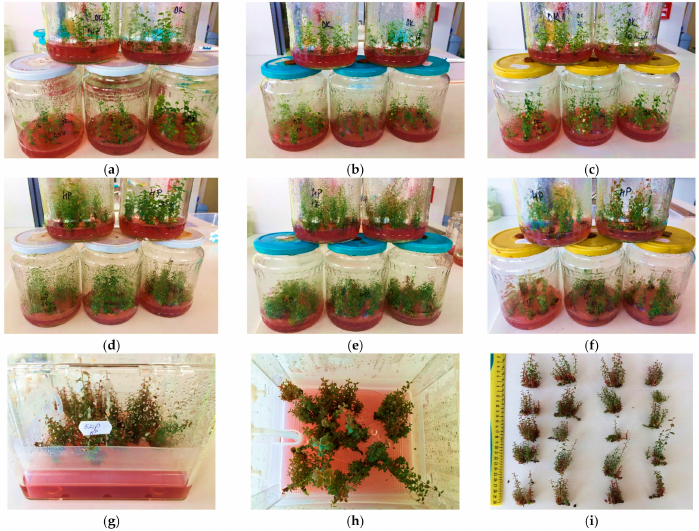
Figure 1. In vitro propagation of V. corymbosum L. cvs Duke and Hortblue Petite: ( a ) Duke after 12 weeks of in vitro culture in WPM medium (McCown’s Woody Plant medium) supplied with 0.5 mg/L zeatin (Z) and gelled with 5 g L Plant agar; ( b ) Duke after 12 weeks of in vitro culture in WPM medium supplied with 1 mg/L Z and gelled with 5 g/L Plant agar; ( c ) Duke after 12 weeks of in vitro culture in WPM medium supplied with 5 mg/L N6-(2-Isopentenyl) adenine (2iP) and gelled with 5 g/L Plant agar; ( d ) Hortblue Petite after 12 weeks of in vitro culture in WPM medium supplied with 0.5 mg/L Z and gelled with 5 g/L Plant agar; ( e ) Hortblue Petite after 12 weeks of in vitro culture in WPM medium supplied with 1 mg/L Z and gelled with 5 g/L Plant agar; ( f ) Hortblue Petite after 12 weeks of in vitro culture in WPM medium supplied with 5 mg/L 2iP and gelled with 5 g/L Plant agar; ( g – i ) Hortblue Petite after 12 weeks of in vitro culture in WPM medium supplied with 5 mg/L 2iP in